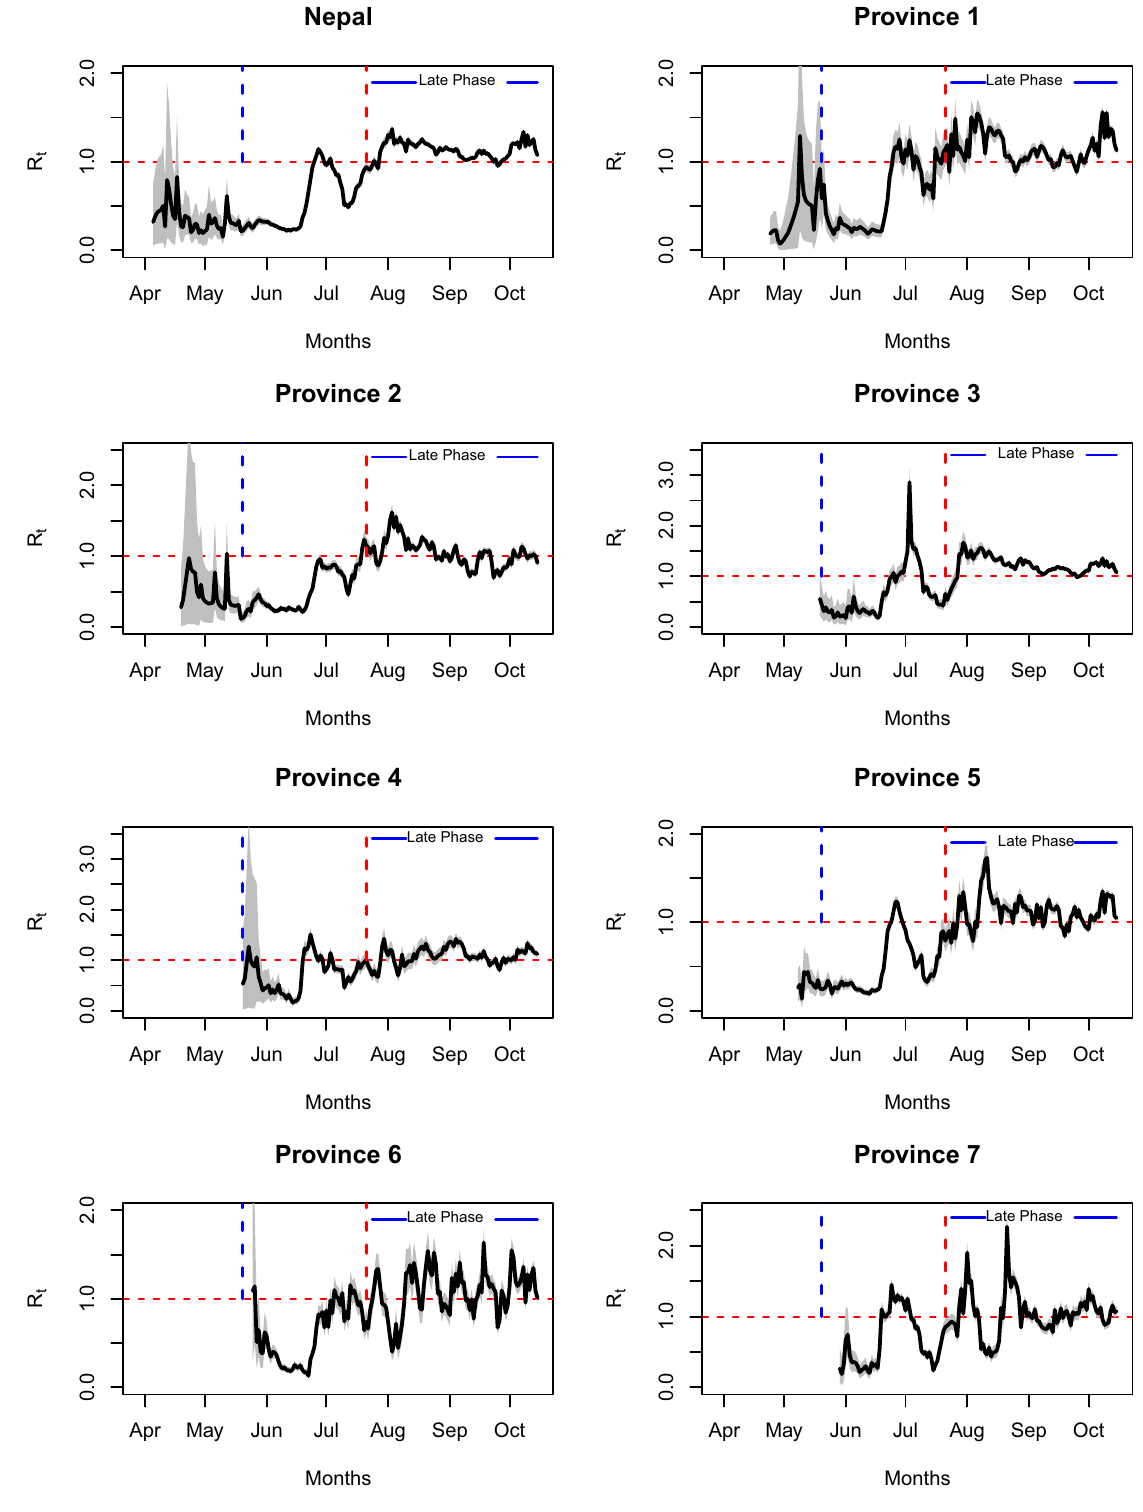
Figure 4. The time-dependent effective reproduction number of COVID-19 for Nepal and its seven provinces during 2020 pandemic. The gray shaded region is the 95% confidence interval for R t . The solid curve in the middle of the gray area is the average effective reproduction number. The vertical blue dotted lines indicate the start date of border opening with screening and the vertical red dotted lines indicate the date at which the countrywide lockdown was ended, after which the epidemic is described as the late phase (solid blue line). The horizontal red dotted lines indicate the effective reproduction number of